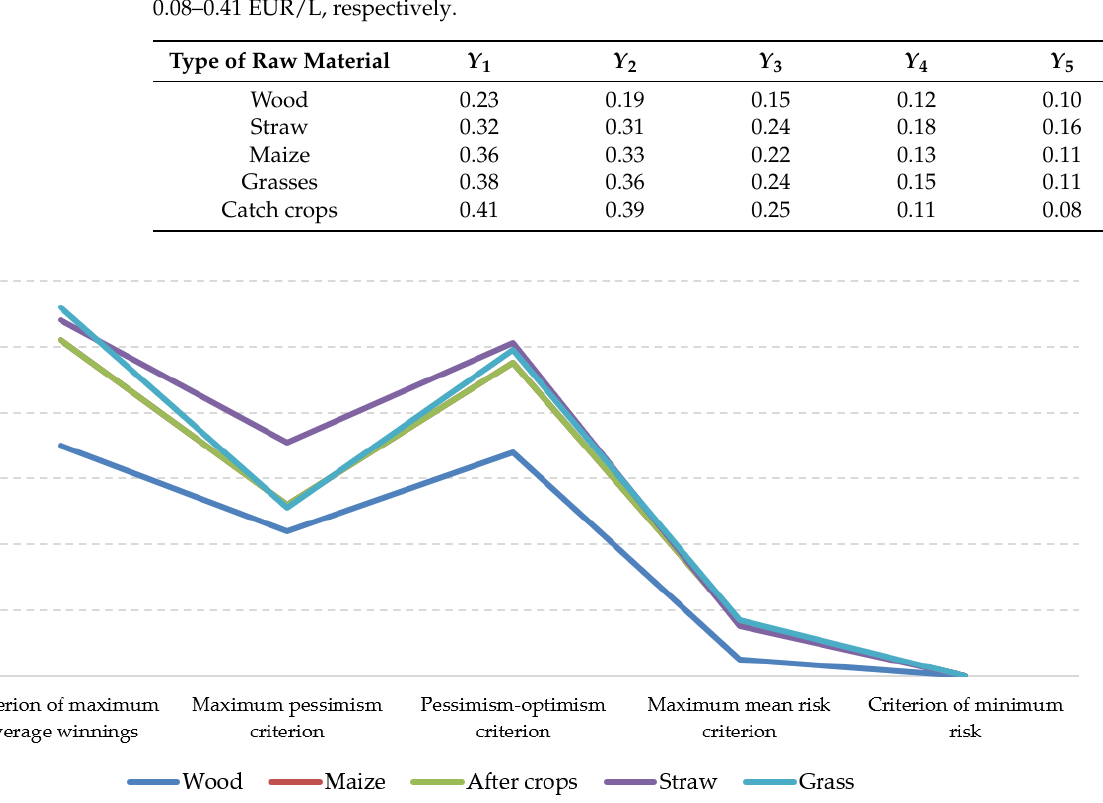
Figure 6. Possibilities of production of second-generation bioethanol in Poland according to indi- vidual choice